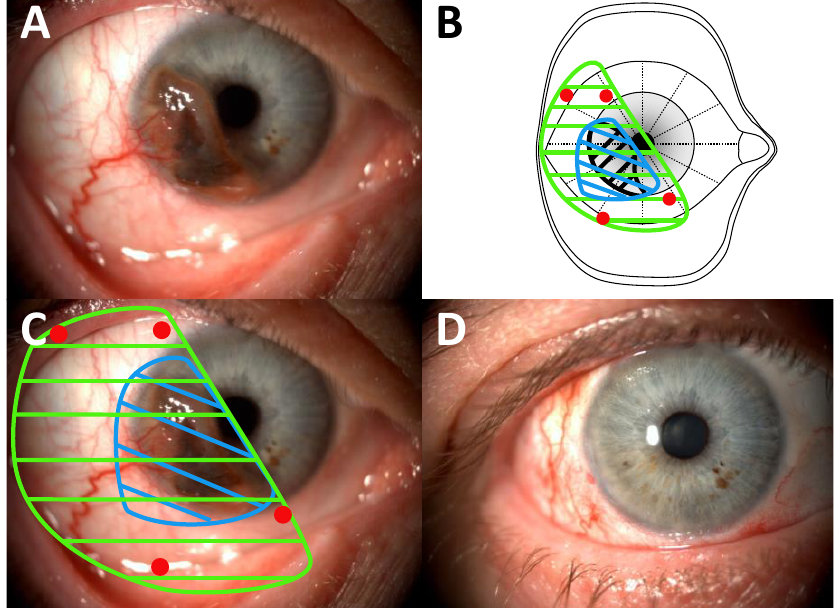
Figure 3. Adjuvant proton beam irradiation plan for conjunctival melanoma (CM). ( A ) CM before surgical resection; ( B ) Drawing of the treatment plan on the tantalum clip positioning diagram; ( C ) Simulation of the treatment plan on the preoperative primary position photography; ( D ) Clinical aspect 1 year after treatment.